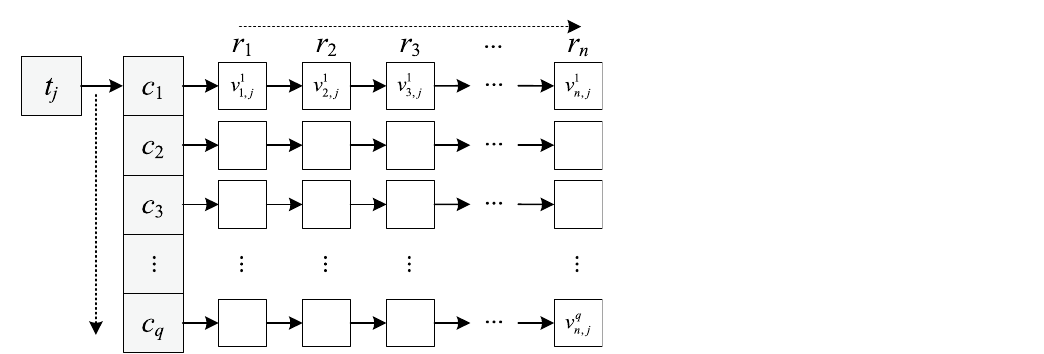
Figure 3. The tree structure of multi-channel lidar data.